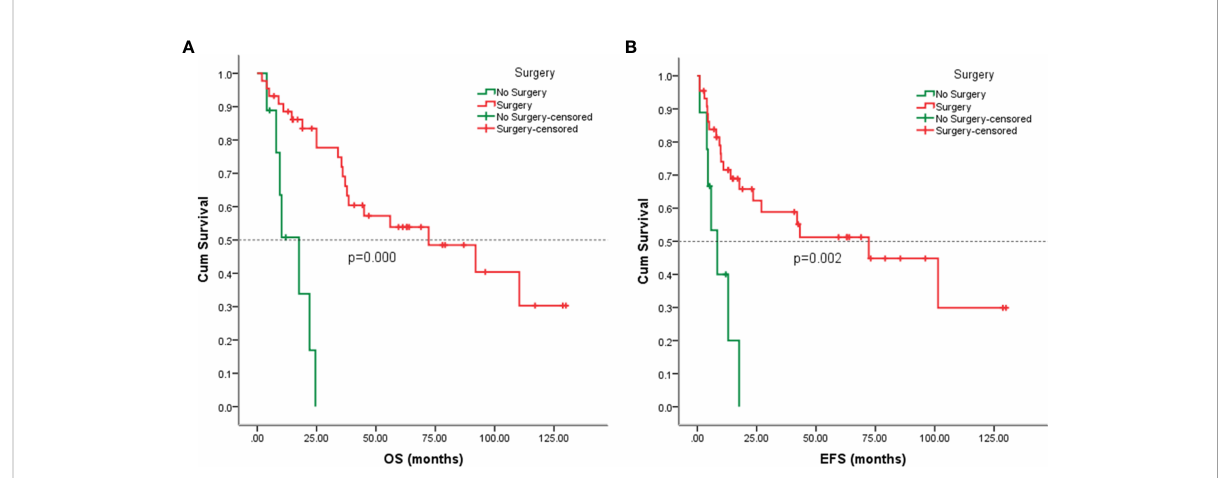
FIGURE 4 Kaplan-Meier analysis of OS and EFS for patients with or without surgery. (A) Kaplan-Meier analysis of OS for patients with or without surgery (p=0.000). (B) Kaplan-Meier analysis of EFS for patients with or without surgery (p=0.002).